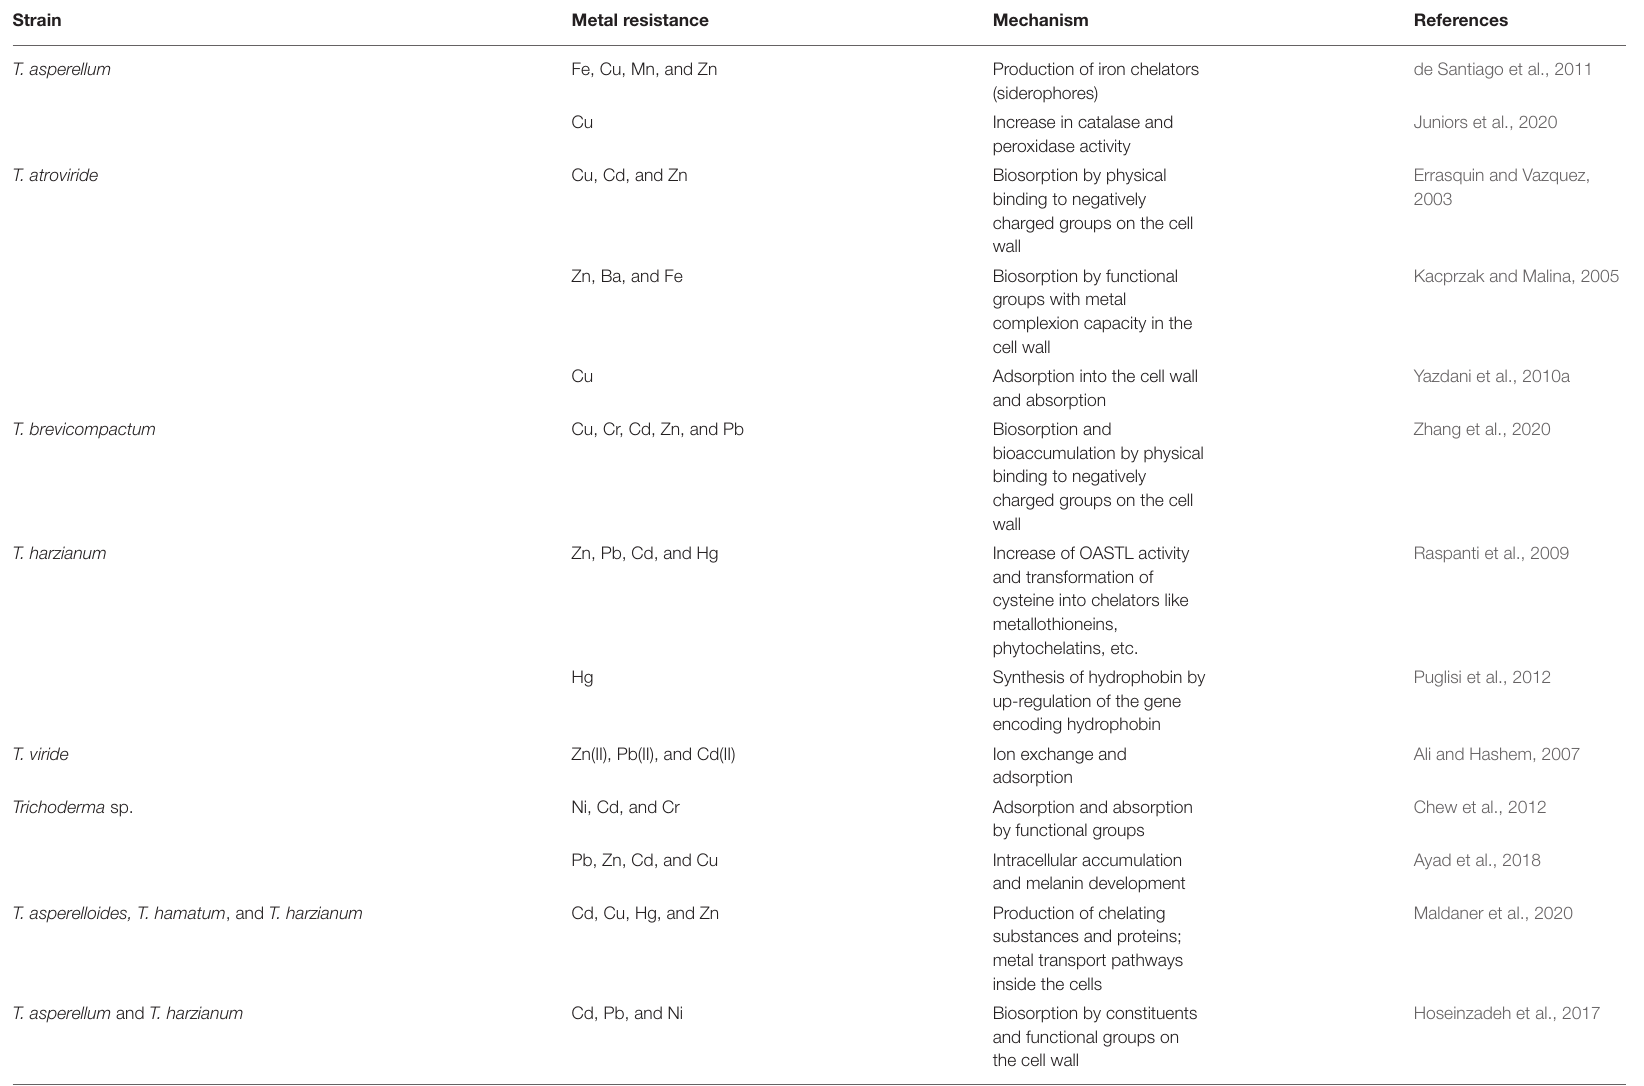
TABLE 2 | Mechanisms of tolerance to metals in Trichoderma